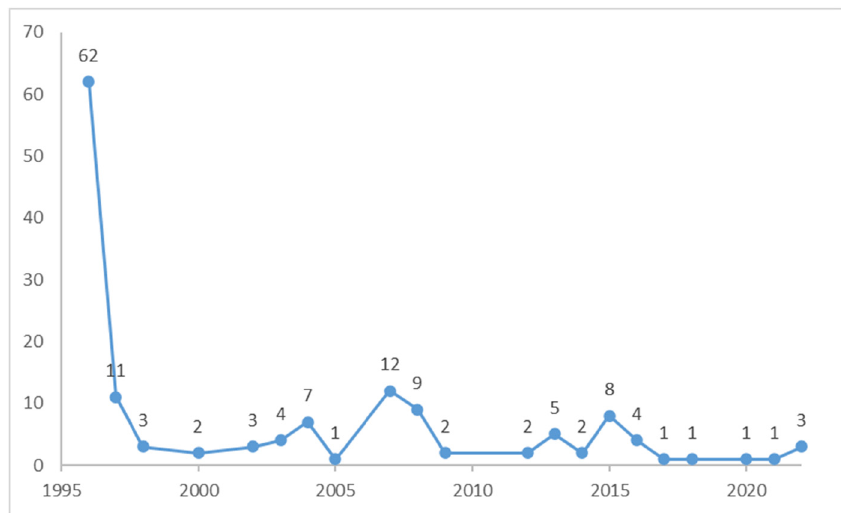
Figure 1: Evolution of registered agri - food products in Portugal. Source: Own computation based on data gathered from eAmbrosia ( July 2022 )